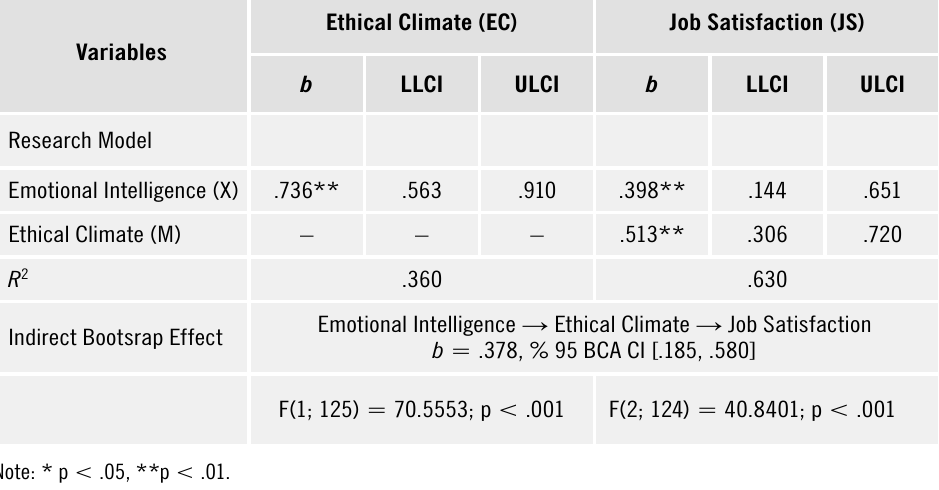
Table 3. Bootstrapping regression analysis results (N =